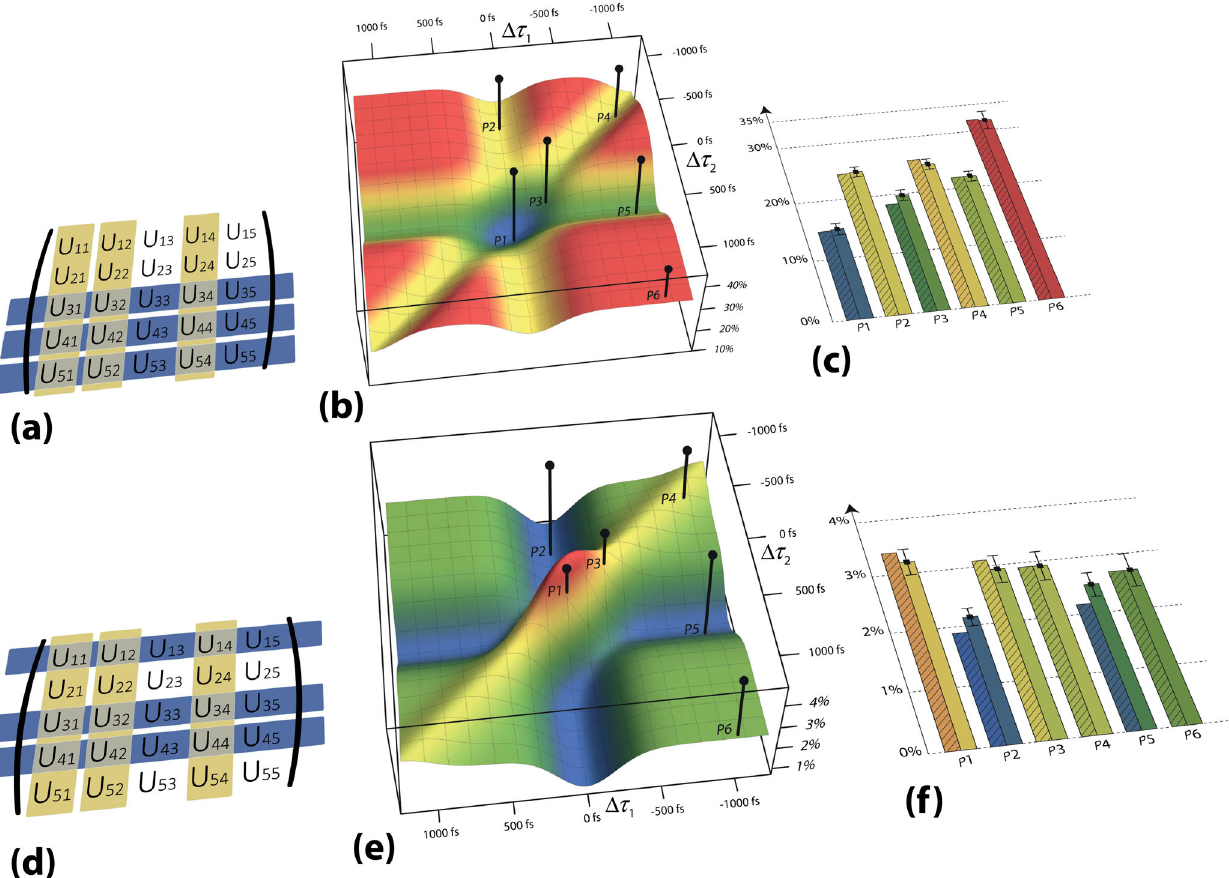
FIG. 3. Three-photon coincidence landscapes. Three photons enter the interferometric network, one each in modes 1, 2, and 4 (highlighted in yellow), and exit the network in modes (a) 3, 4, and 5 and (d) 1, 3, and 4, respectively (highlighted in blue). The intersections of the inputs ’ columns and the outputs ’ rows uniquely select matrix entries that constitute 3 × 3 submatrices. Tuning the temporal delay of the three photons with respect to each other ( Δ τ 1 and Δ τ 2 ) gives rise to coincidence landscapes [(b) and (e)]. Their temporal distinguishability determines the degree of nonclassical interference and therefore the probability to detect such an event. Six characteristic points ( P 1 – P 6 ) of each landscape are experimentally sampled. Theoretical prediction (left bars, shaded) and experimentally obtained output probabilities (right bars) for the six points and both output combinations are shown in (c) and (f). The reduced χ 2 is 1.38 and 1.10, respectively, and the experimental errors are calculated as standard